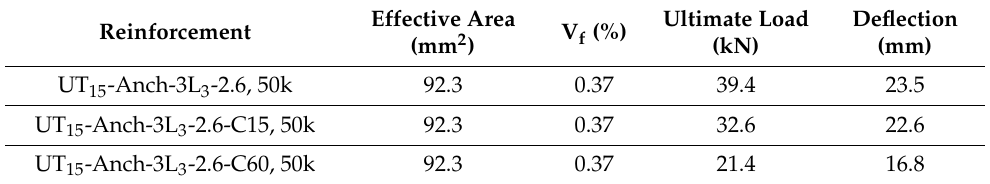
Table 11. The effects of cover thicknesses on the performance of TRC beams.